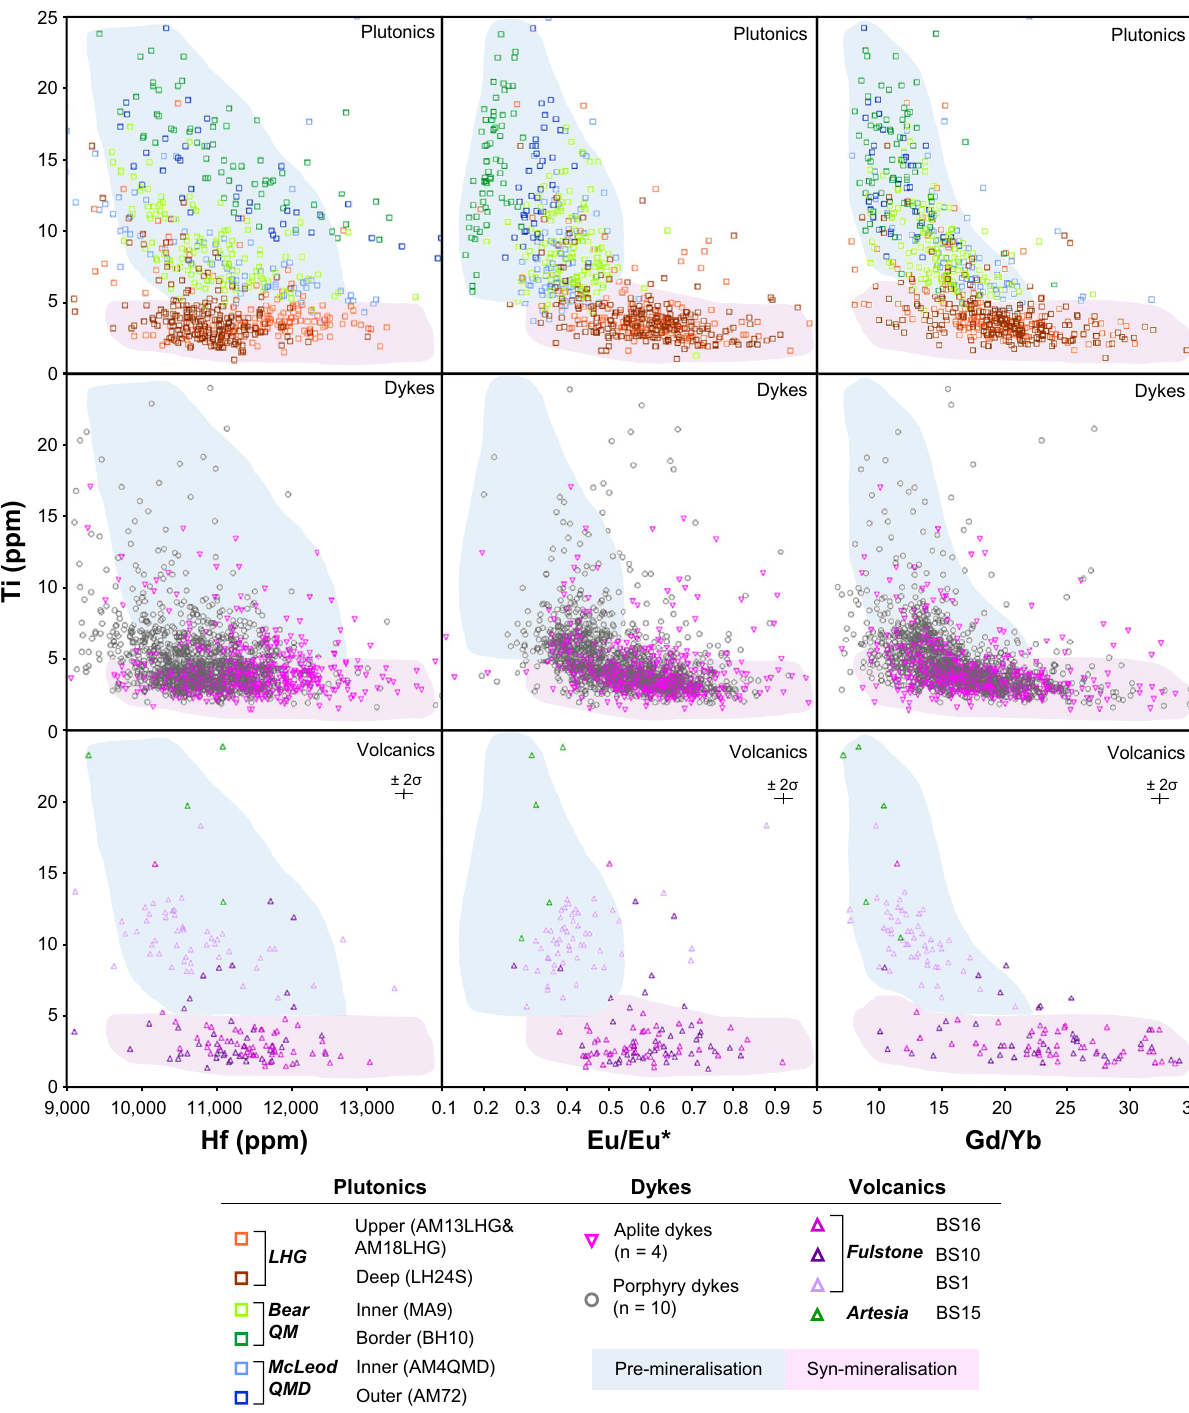
Figure 7. Zircon trace element signatures through the Yerington magmatic system: Zircon LA-ICP-MS trace element data from samples spanning, temporally and spatially, the Yerington magmatic system. ‘Pre- mineralisation’ and ‘syn-mineralisation’ fields shaded to aid visualisation, based on the dominant zircon geochemical signatures of the plutonic units and projected onto the plots for dykes and volcanics. Only zircon rim data have been plotted. See Fig. S13–S15 for full sample breakdown along with zircon core